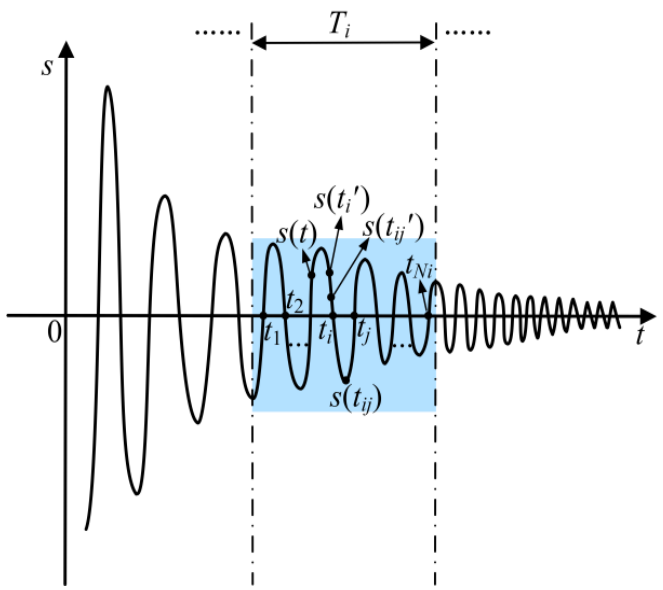
Figure 4. Online zero-crossing detection in a sampling interval.